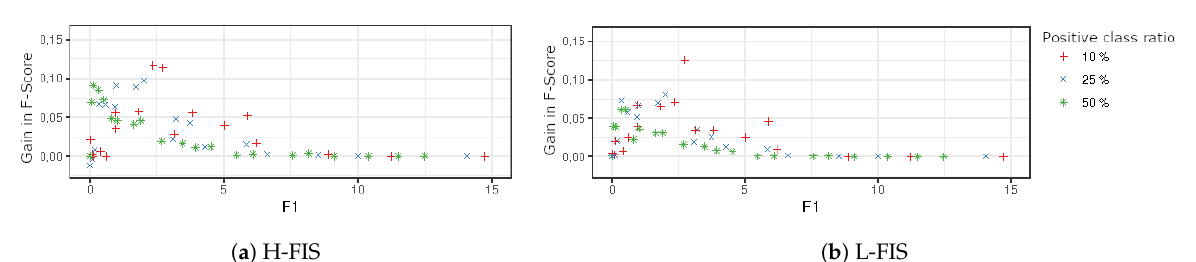
Figure 9. Graphs that represent the effect of the H-FIS ( a ) and L-FIS ( b ) on F-Score in the artificial datasets segregated by imbalance.